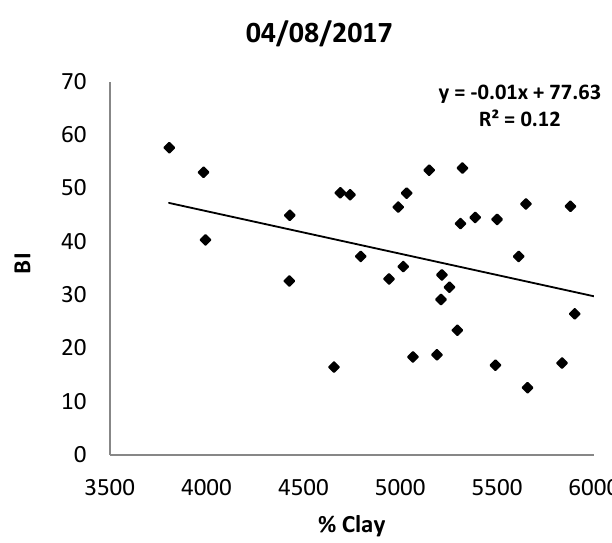
Figure 7. Brightness index as a function of clay content.